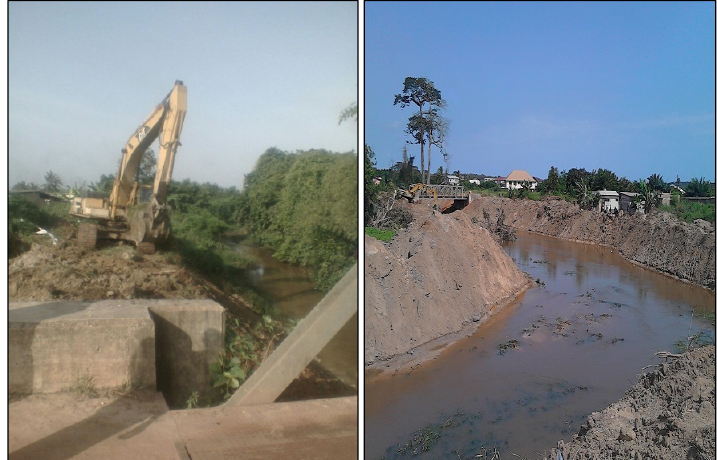
Figure 7. ( left ) before dredging of Kakum River at Kwapro; ( right ) after dredging of Kakum River at Kwapro in 2016 (Credit: Central Regional NADMO Secretariat, Cape Coast).